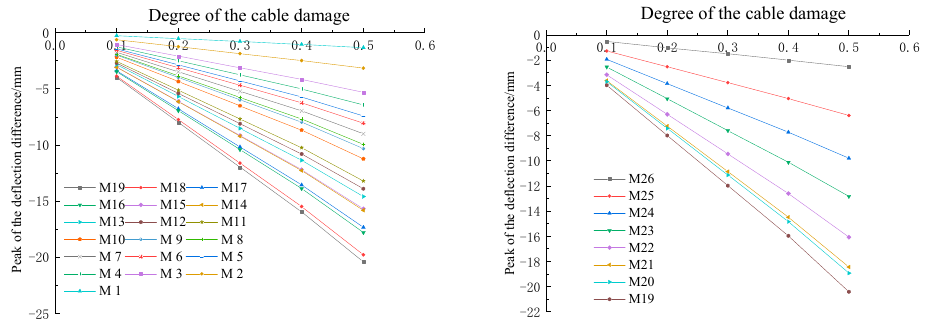
Figure 9. The variation of peak value of the deflection difference with damage degree.